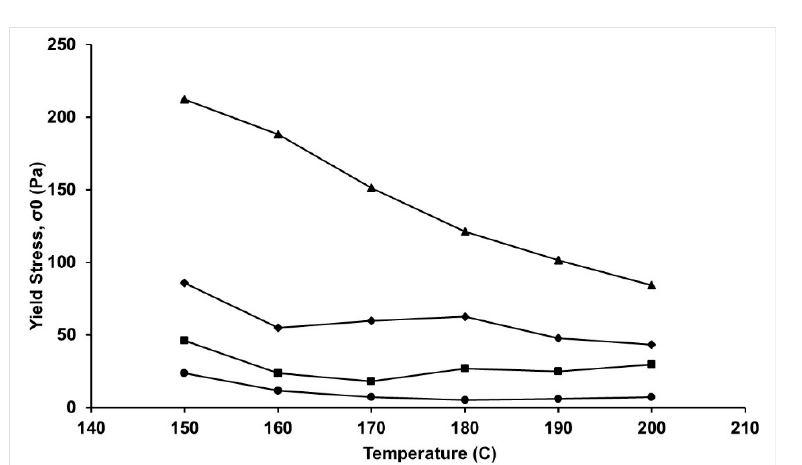
Figure 7. Solution yield stress for PAN and PAN-BL blends as a function of temperature; (cid:8) —PAN; (cid:4) —PAN-10%wt BL; (cid:117) —PAN-20%wt BL; (cid:78) —PAN-30%wt